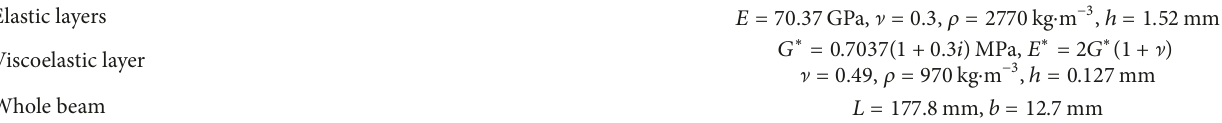
Table 3: Material and geometrical properties.